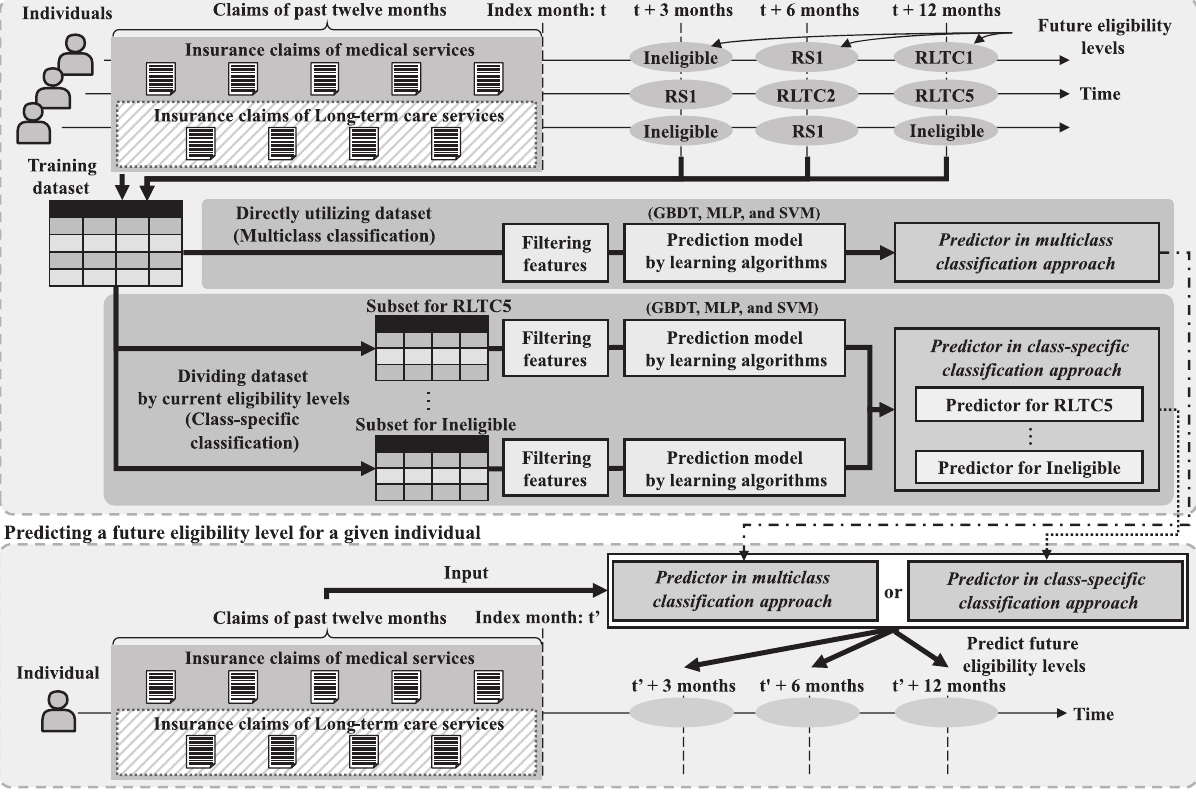
Fig. 1 Study framework for future prediction of individuals ’ long-term care eligibility